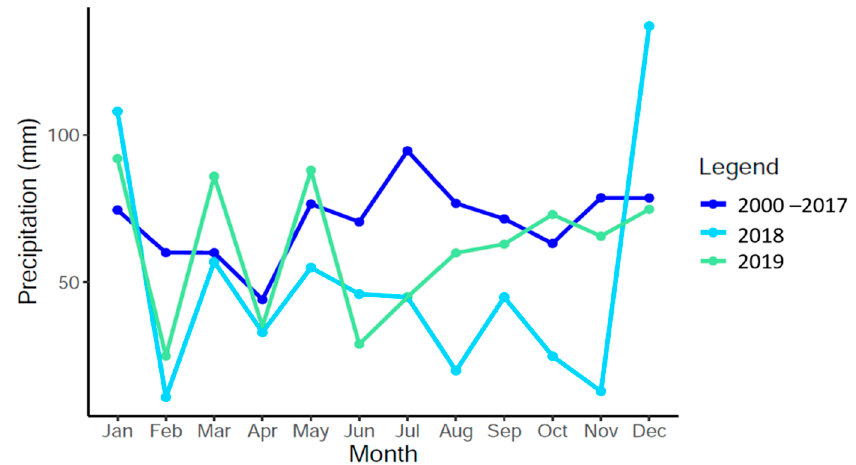
Figure 2. Monthly average precipitation from January to December for the period 2000–2017, 2018, and 2019 at the study site. The precipitation data were extracted from the raster dataset (1 × 1 km) of the German Meteorological Service.